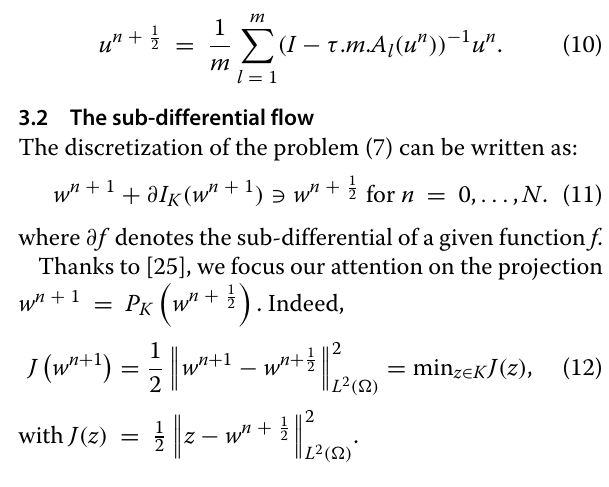
Table 1 PSNR and SNR values for the noisy and recovered images corresponding to the experiments shown in Figs. 2 and 3